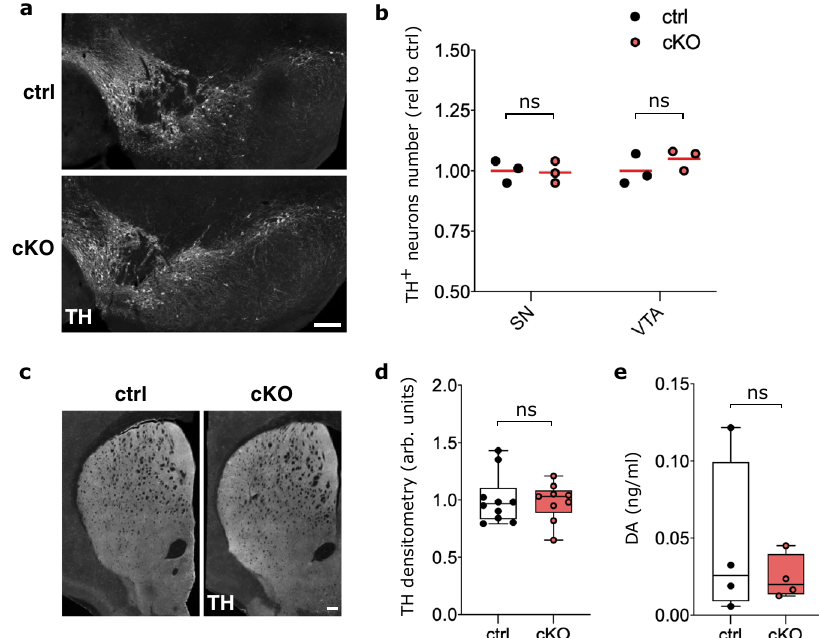
Fig. 7 Nato3 cKO in DA neurons does not affect neuronal integrity and striatal DA levels. a Representative TH immunostaining images of coronal ventral midbrain sections from 16- to 18-month-old control and Nato3 cKO mice. Scale bar, 200 µ m. b Quanti fi cation of TH + neurons in SN and VTA from ( a ). Data are represented as scatter dot plots, with the horizontal line representing the mean of the fold change relative to the ctrl. n = 3 mice per genotype. No statistically signi fi cant difference between ctrl and cKO by two-tailed Mann-Whitney test. c Representative TH immunostaining images of coronal striatal sections from 16- to 18-month-old control and Nato3 cKO mice. Scale bar, 200 µ m. d Optical densitometry from TH immunostaining of the dorsal striatum in ( c ). Data are represented as fold change relative to the expression level in the ctrl. n = 10 sections (ctrl) and n = 9 sections (cKO) from 4 mice per genotype. No statistically signi fi cant difference between ctrl and cKO by two-tailed Mann – Whitney test. e Basal levels of extracellular DA (ng/ μ l) in microdialysis perfusate from striatum of control and Nato3 cKO mice. n = 4 mice per genotype. No statistically signi fi cant difference between ctrl and cKO by two-tailed Mann – Whitney test. Box boundaries in ( d ), and ( e ) are the 25th and 75th percentiles, the horizontal line across the box is the median, and the whiskers indicate the minimum and maximum